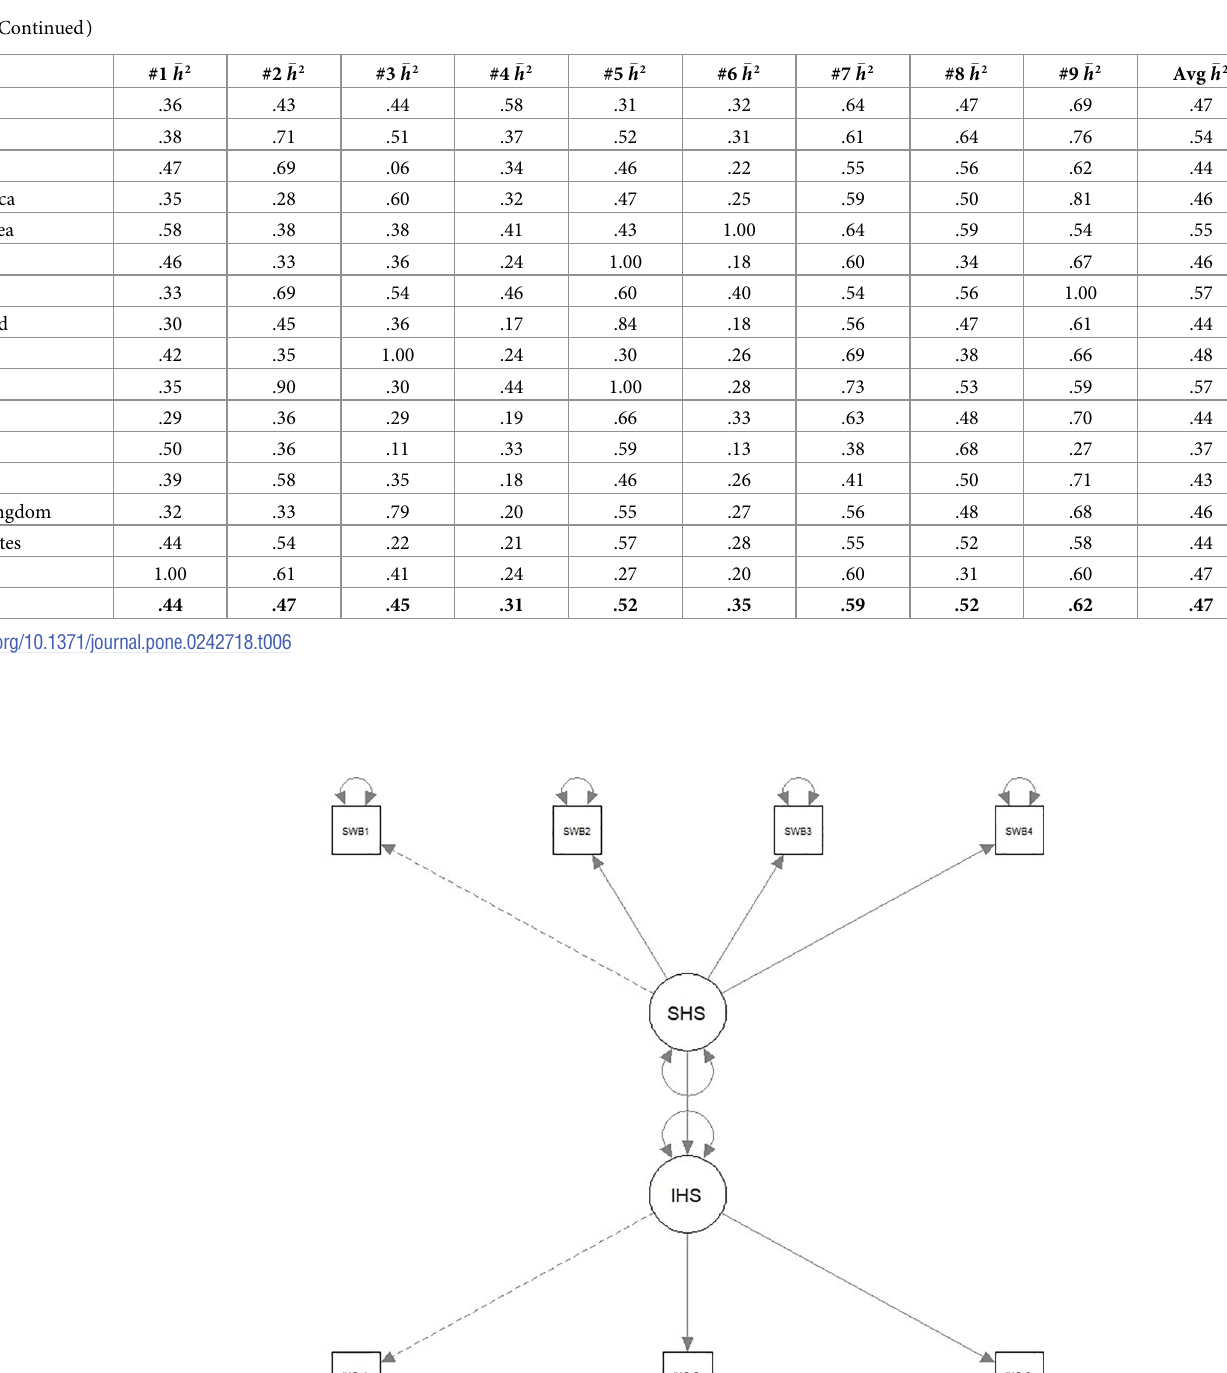
PLOS ONE | https://doi.org/10.1371/journal.pone.0242718 December9,